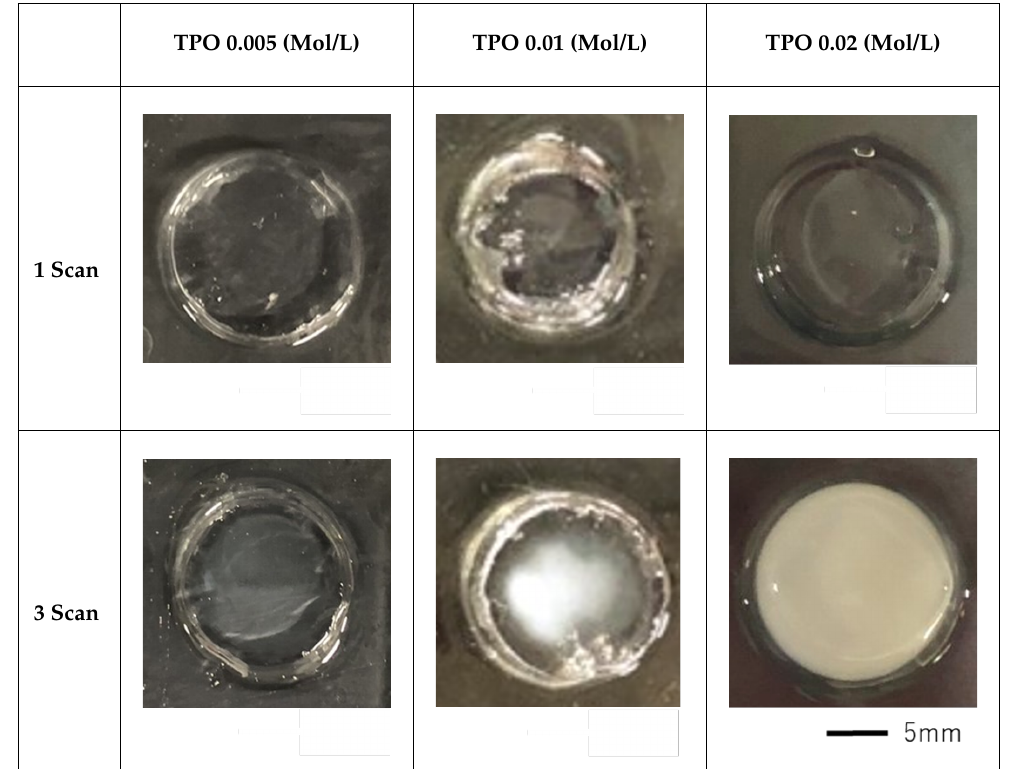
Figure 3. The photos of 3D printed bilayer gels of the hydrogel sheet without/with the hinge structure during swelling process. The left half side of all the gels is bonded on glass plate. The right half side in not bonded and then can lift up in the swelling process. The red angles indicate the degree of bending deformation. Table 1. Photographs of 3D printed one-layer gels in the various concentrations of the initiator TPO and in the one or three scanning numbers of UV irradiation in 3D